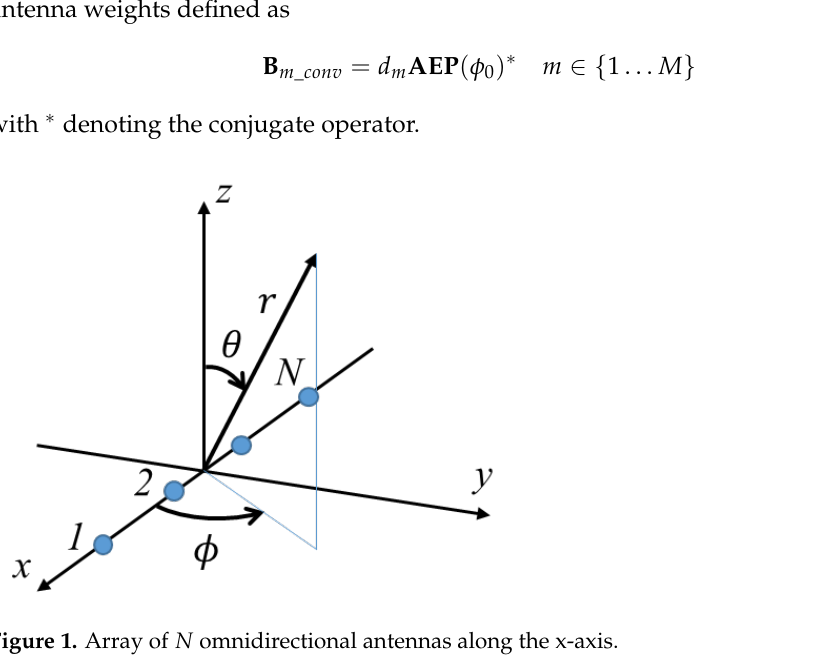
Figure 1. Array of N omnidirectional antennas along the